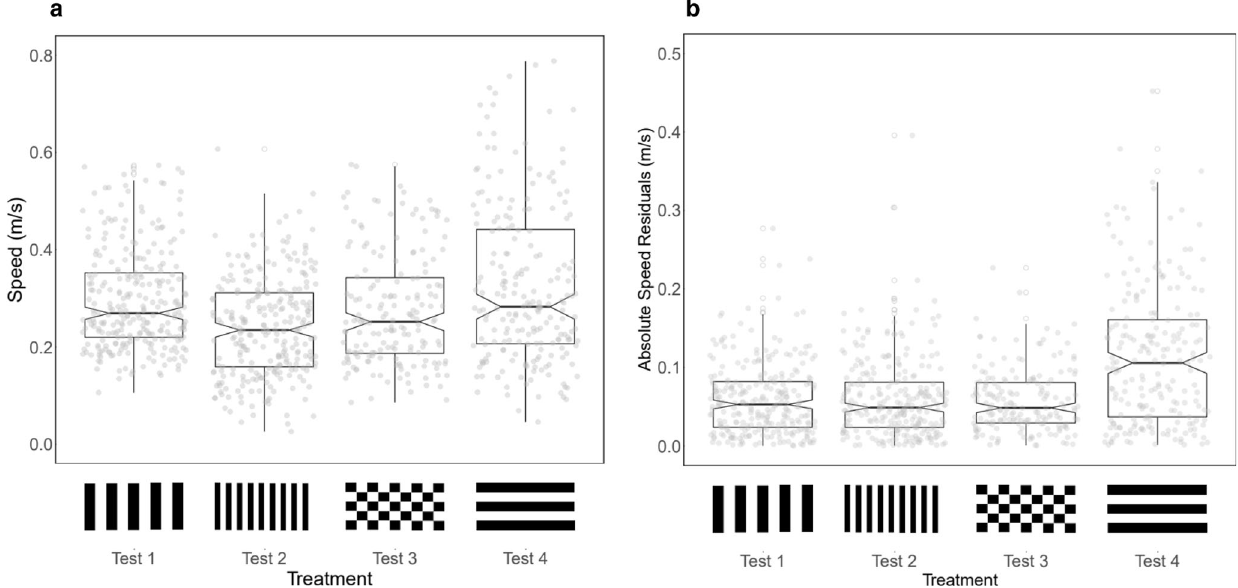
Fig. 4 Swimming speeds across treatments. a Mean swimming speeds varied with visual treatment but not proportionately with the modi fi cations in spatial frequency. b The variability in swimming speed, measured as the residual swimming speeds from the treatment mean, increased with removal of translational optic fl ow. Box plots indicate the median, interquartile range, and notches compare medians between groups. Grey points indicate individual trials. Sample sizes across fi sh and treatments were as follows. Test 1: n = 268 (By fi sh: A, n = 43; B, n = 45; C, n = 45; D, n = 45; E, n = 45; F, n = 45),